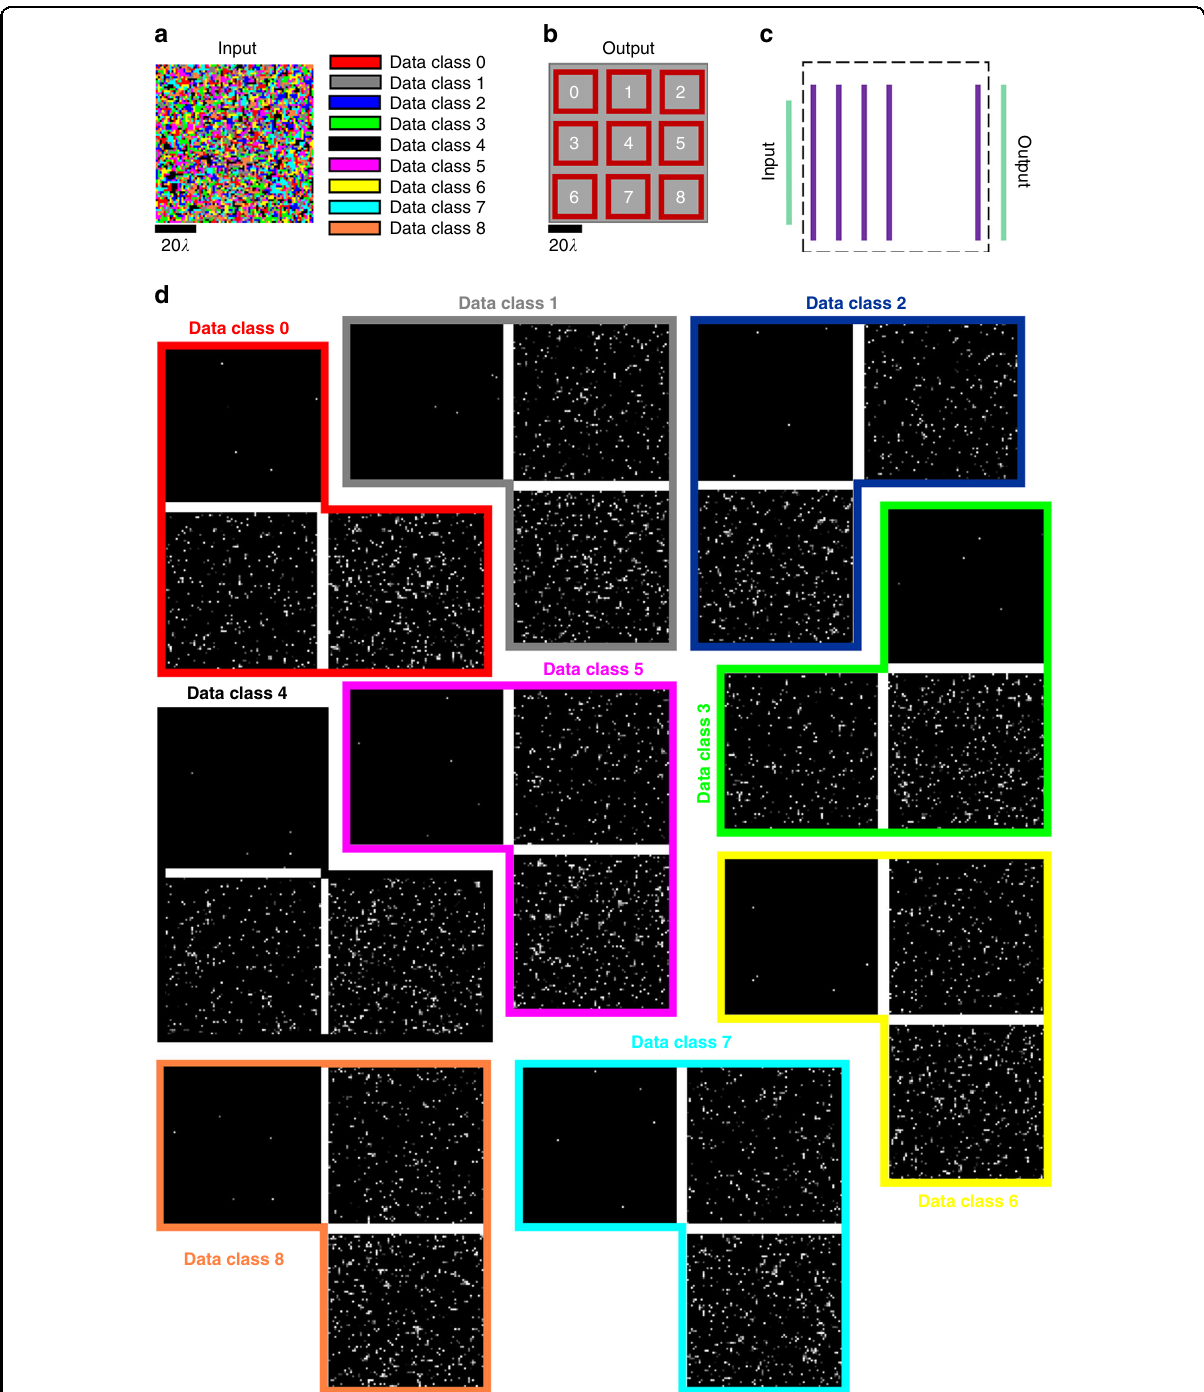
Fig. 3 Spatially encoded image classi fi cation dataset. a Nine image data classes are shown (presented in different colors), de fi ned inside the input fi eld-of-view (80 λ × 80 λ ). Each λ × λ area inside the fi eld-of-view is randomly assigned to one image data class. An image belongs to a given data class if and only if all of its nonzero entries belong to the pixels that are assigned to that particular data class. b The layout of the nine class detectors positioned at the output plane. Each detector has an active area of 25 λ × 25 λ , and for a given input image, the decision on class assignment is made based on the maximum optical signal among these nine detectors. c Side view of the schematic of the diffractive network layers, as well as the input and output fi elds-of-view. d Example images for nine different data classes. Three samples for each image data class are illustrated here, randomly drawn from the three test datasets (Te 1 , Te 50 , and Te 90 ) that were used to quantify the blind inference accuracies of our diffractive network models (see Fig.